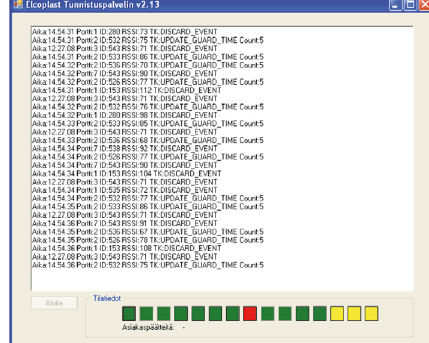
Figure 15: An example of a print screen screenshot